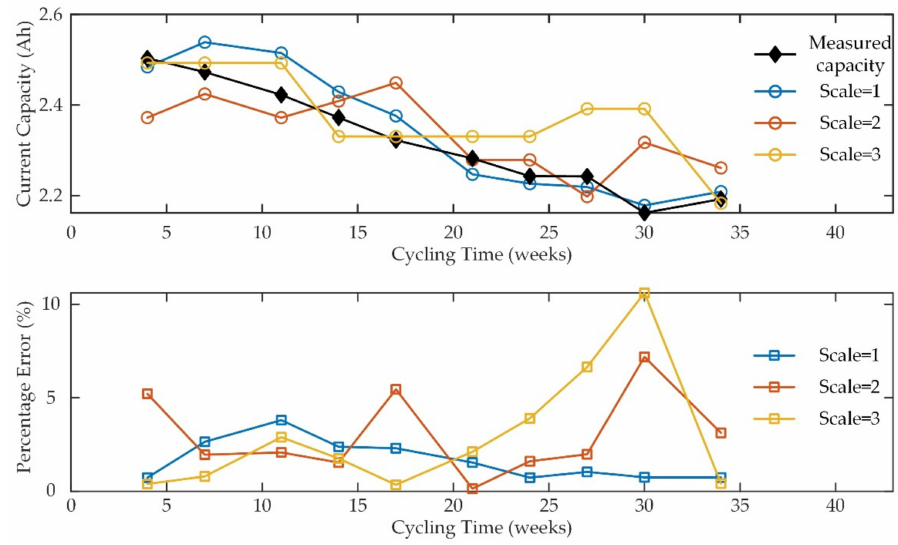
Figure 15. Curve of the multiscale sample entropy and their polynomial fitting results. ( a ) Curve of the calculated multiscale sample entropy during the cycling of the tested battery cell; ( b ) First-order polynomial fitting results between the calculated multiscale sample entropy and measured capacity.